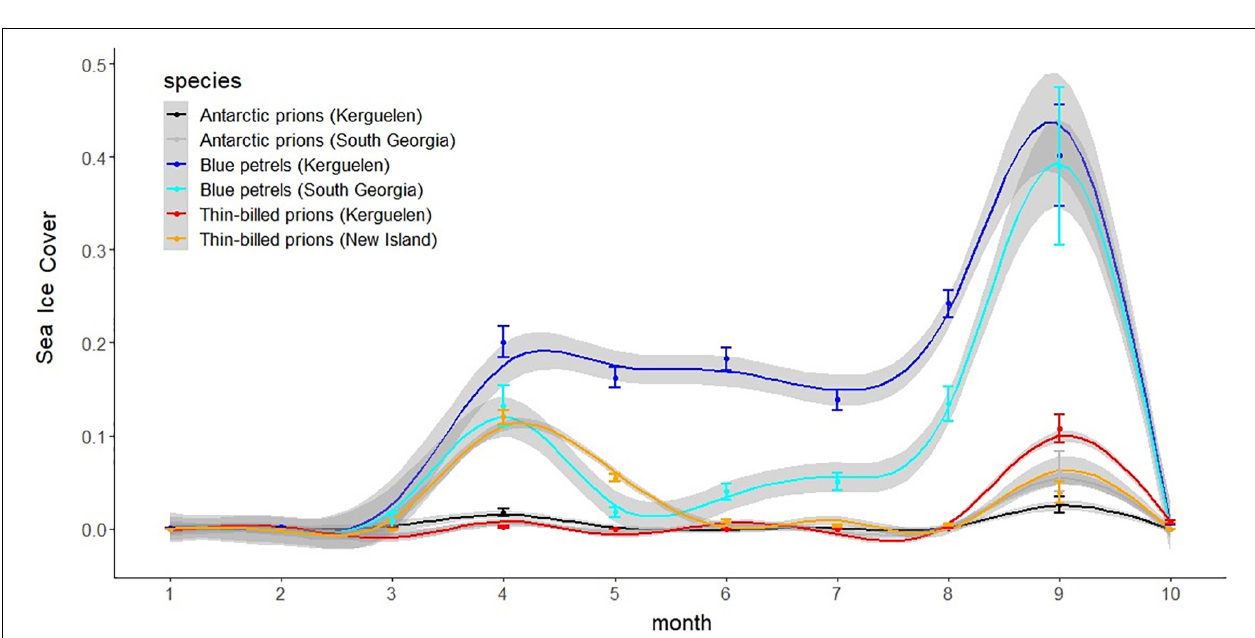
FIGURE 10 | Year-round percentage of sea-ice concentration (mean ± SD, and smooth lines with 95% confidence intervals) of geolocator tracked Blue Petrels, Thin-billed Prions, and Antarctic Prions.